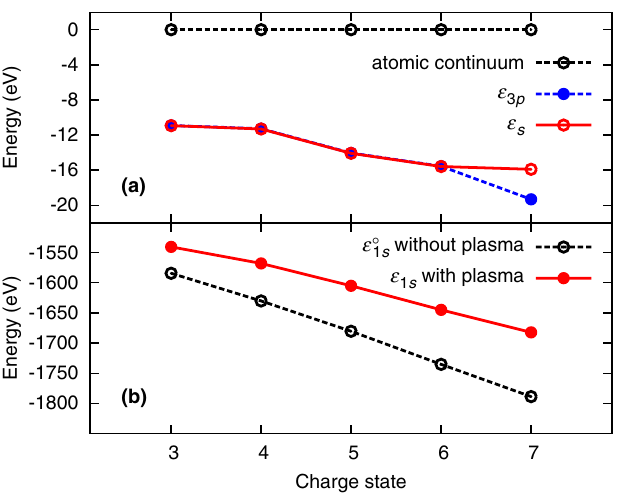
FIG. 5. Energy levels as a function of the charge state for aluminum. (a) The 3 p orbital energy and the threshold energy to the continuum ( ε s ) calculated with the two-step HFS approach. The threshold energy to the continuum for isolated ions ( ε ¼ 0 ) is shown for reference. (b) The 1 s orbital energies without the plasma (unscreened HFS calculations) and with the plasma (two-step HFS calculations).